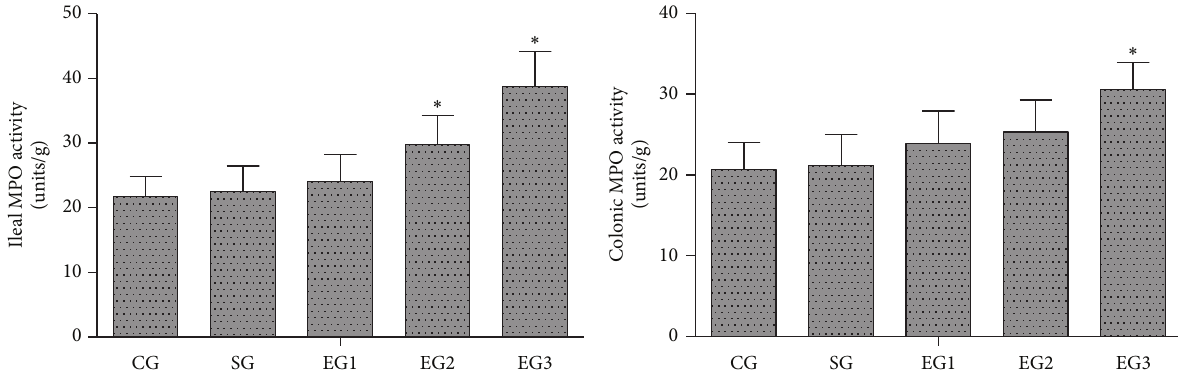
Figure 5: MPO activity in the tissues of ileum and colon. CG: control group; SG: sham group; EG1, EG2, and EG3: exposure groups with peritoneal air exposure for 1, 2, and 3h, respectively. Data are expressed as mean ± SD, 𝑛 = 8 . ∗ 𝑃 < 0.05 , versus the CG